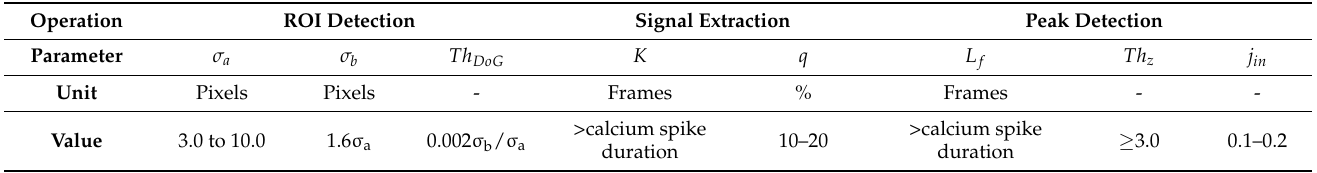
Table 1. The proposed start estimates for the parameters of CALIMA